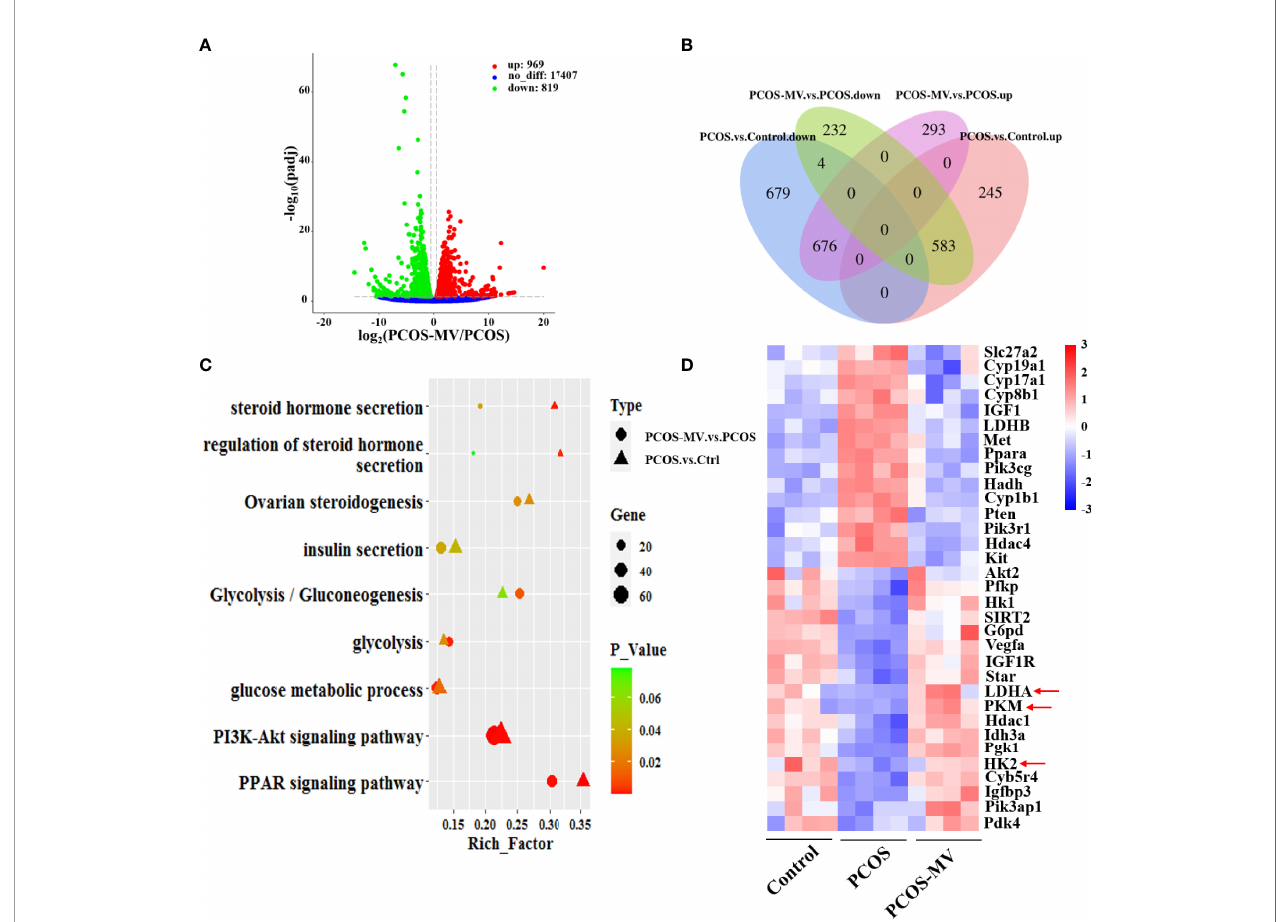
FIGURE 4 | Transcriptome analysis of ovarian tissues. (A) Volcano plot of genes in the comparison of PCOS-MV vs PCOS groups (n = 4). (B) Comparison of common DEGs between the PCOS vs Control and PCOS-MV vs PCOS. (C) Comparison of functional enrichment of DEGs between the PCOS- vs -Control and PCOS-MV vs PCOS. (D) Heatmap of DEGs related to energy and hormone metabolism. up: upregulated. down: